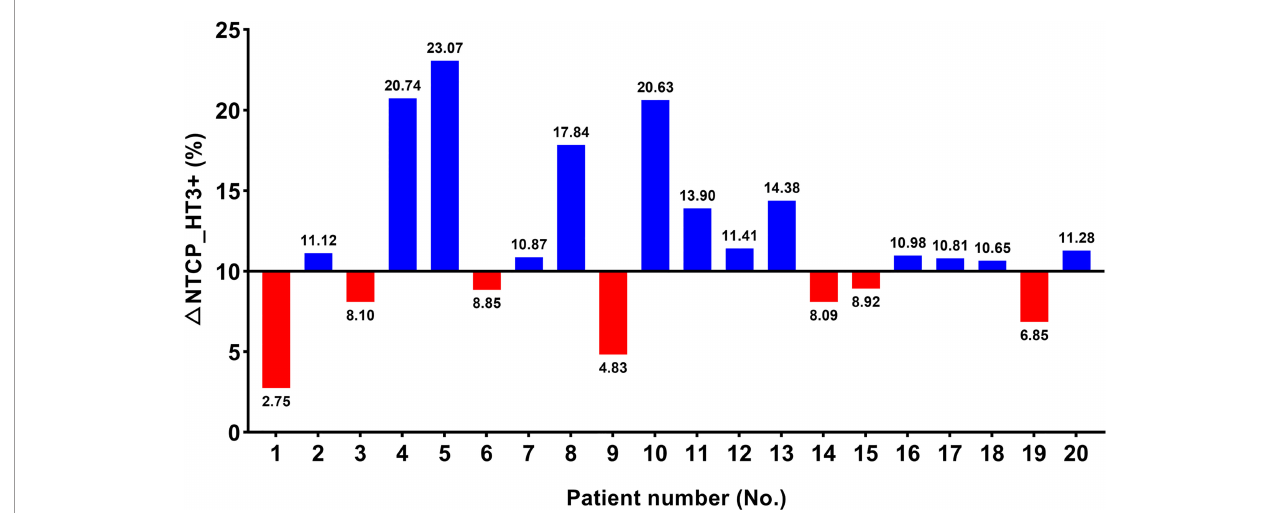
FIGURE 2 | Possibility of grade ≥ 3 hematologic toxicities (HT3+) in twenty patients. △ NTCP_HT3+ ≥ 10% were considered as ‘ bene fi t most from IMPT in terms of HT3+ mitigation ’ .